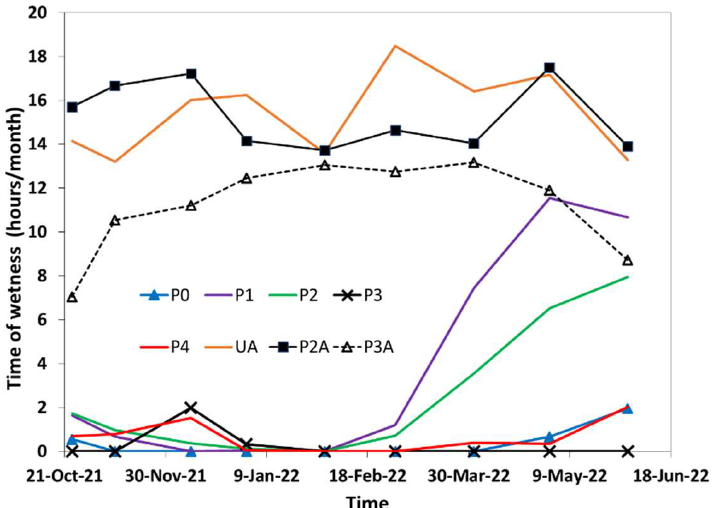
Figure 8. Time of wetness values determined from the measured relative humidity values at all sensors.